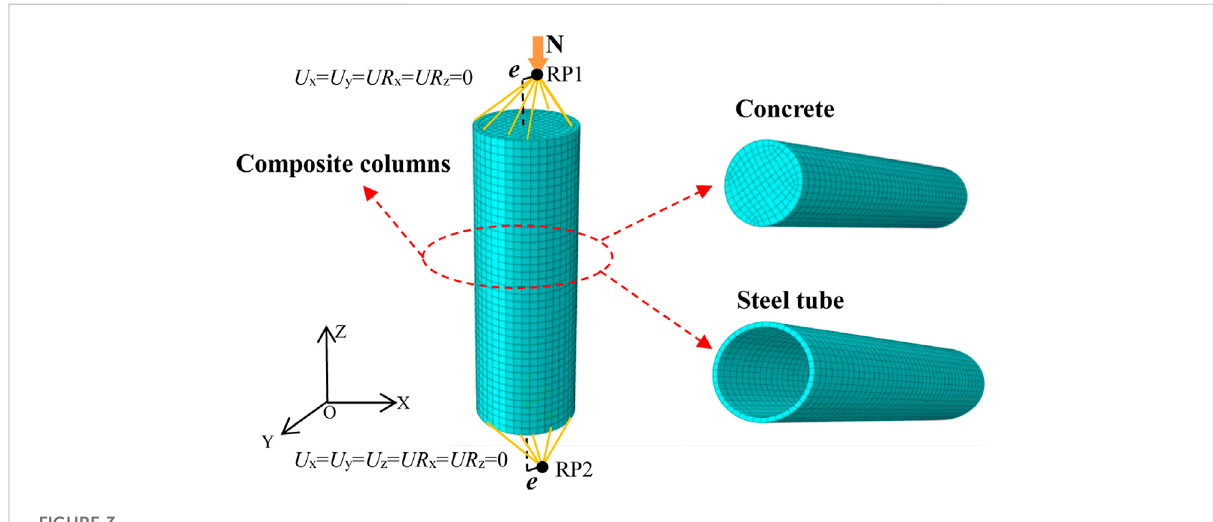
FIGURE 3 The fi nite element model of 34